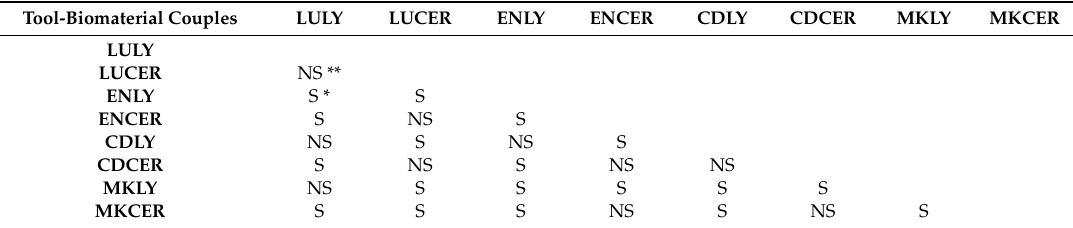
Table 5. Kruskal-Wallis statistical test results for Sa 3D roughness criterion.